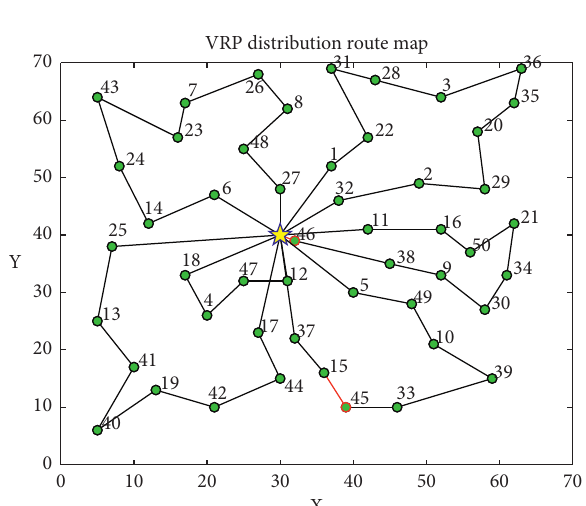
Figure 13: The optimal circuit diagram in this paper.